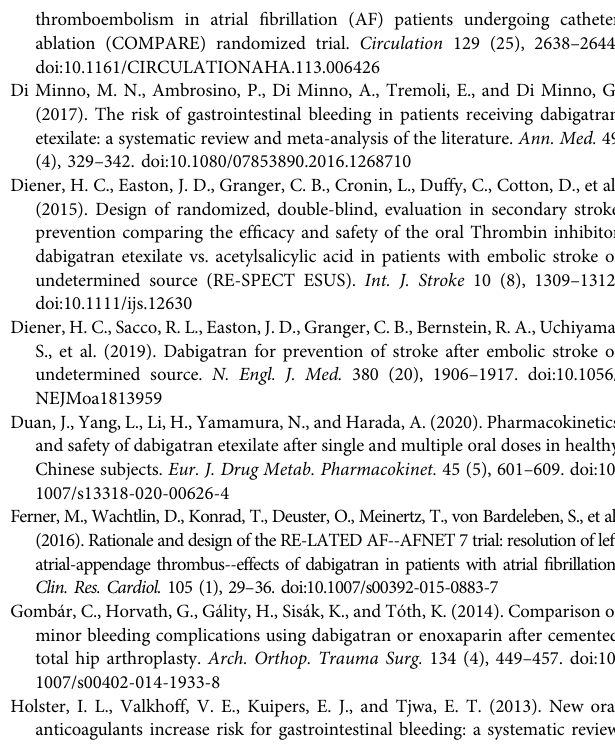
Frontiers in Pharmacology |